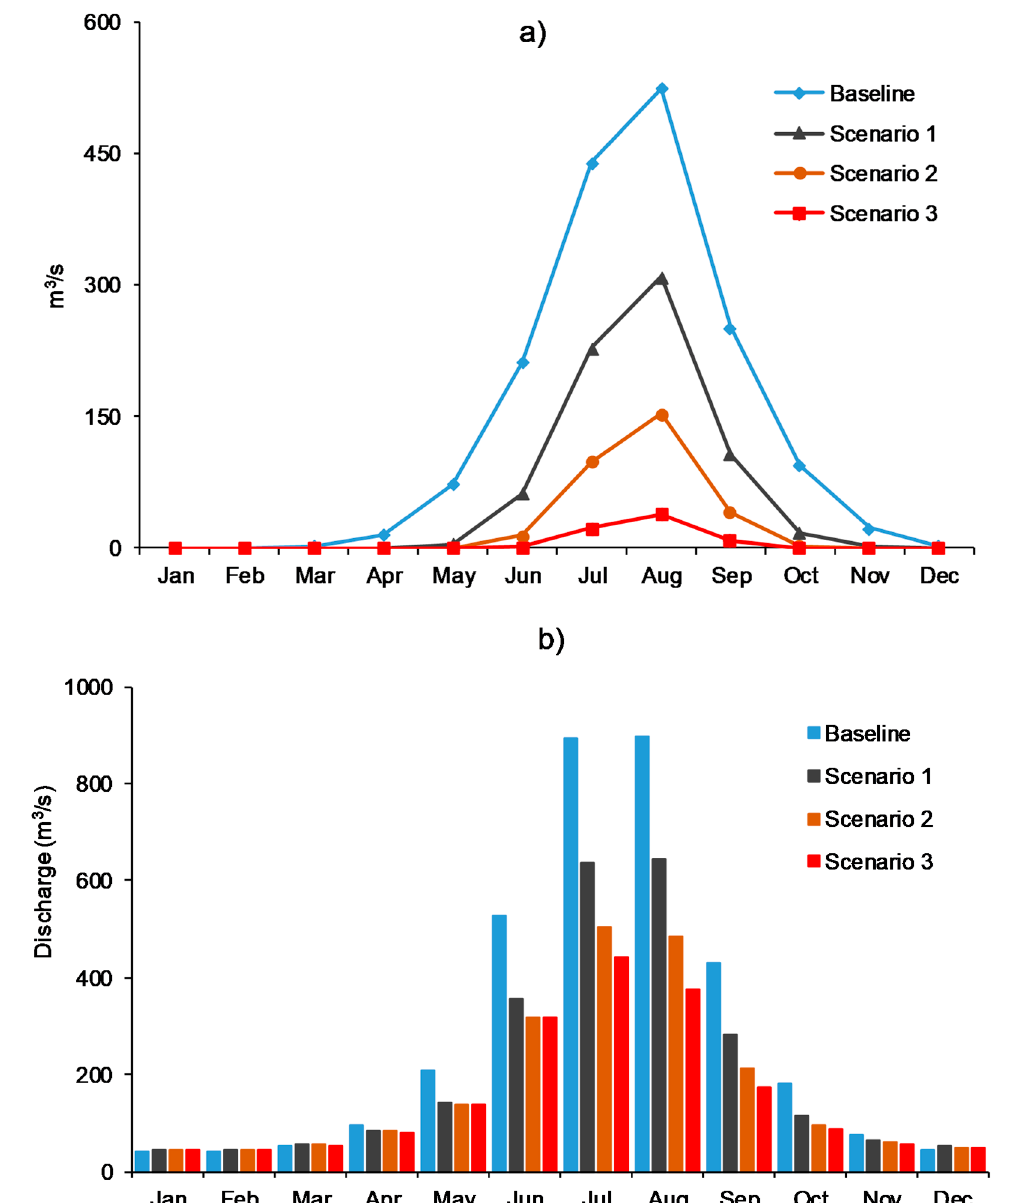
Figure 9. Ice melt and river discharge under different scenarios of glacier recession: ( a ) change in ice melt; ( b ) change in total discharge (Scenarios 1, 2, 3 correspond to recession to 4000, 4500, and 5000 masl, respectively).